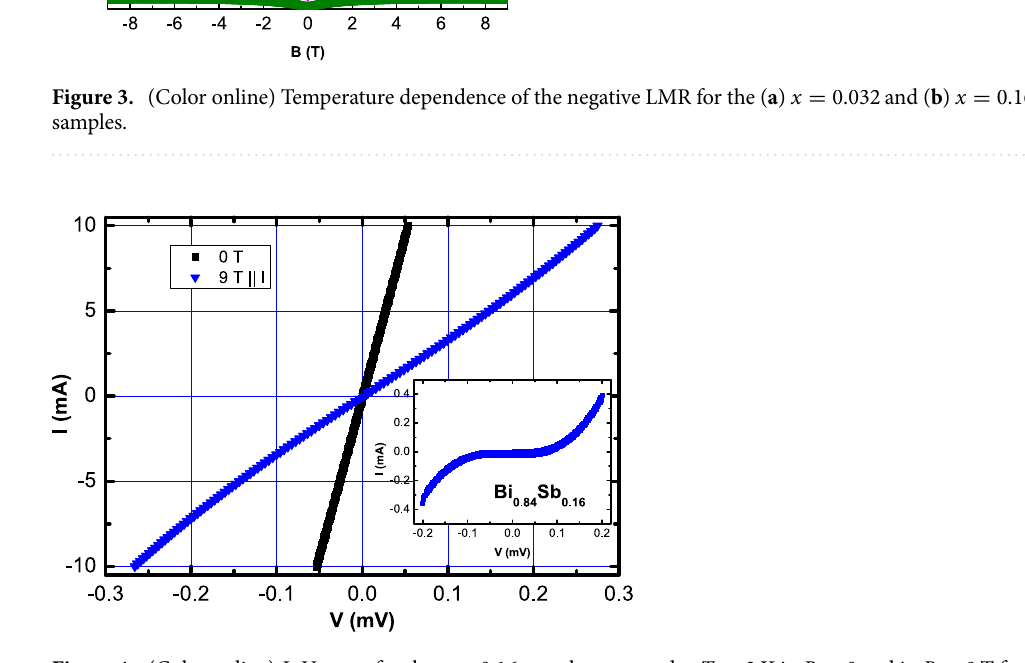
Figure 4. (Color online) I – V curve for the x = 0.16 sample measured at T = 2 K in B = 0 and in B = 9 T for B || I